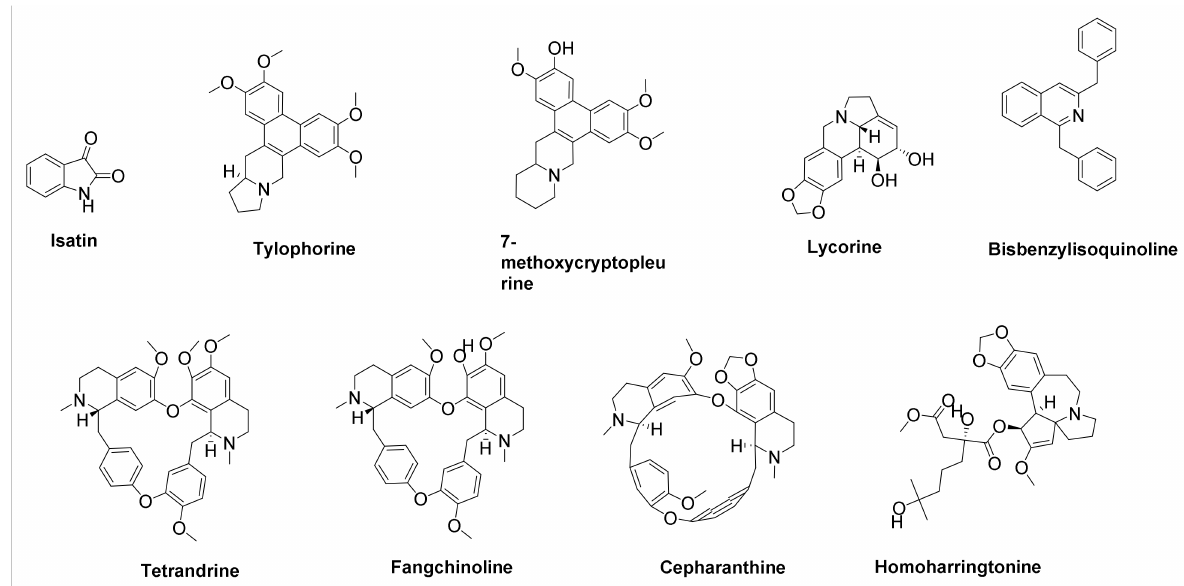
Figure 6. The structures of some effective COVID-19 treatment natural products (alkaloids, polyphenols, flavonoids, and terpenoids